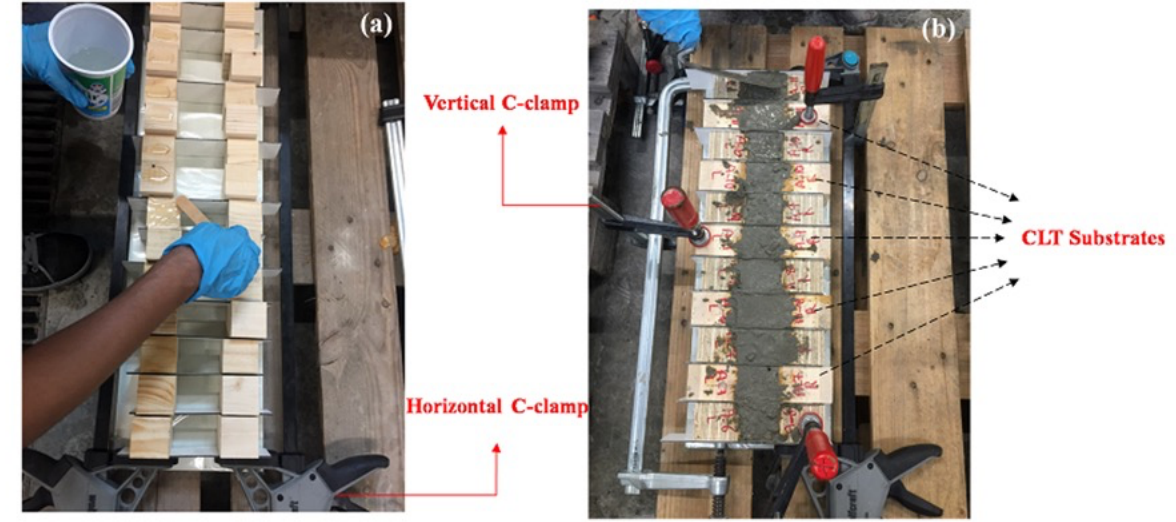
Figure 4. Manufacturing process of wet bond a) pouring and spreading glue on the wood surface b) pouring fresh concrete between wood blocks covered with glue.